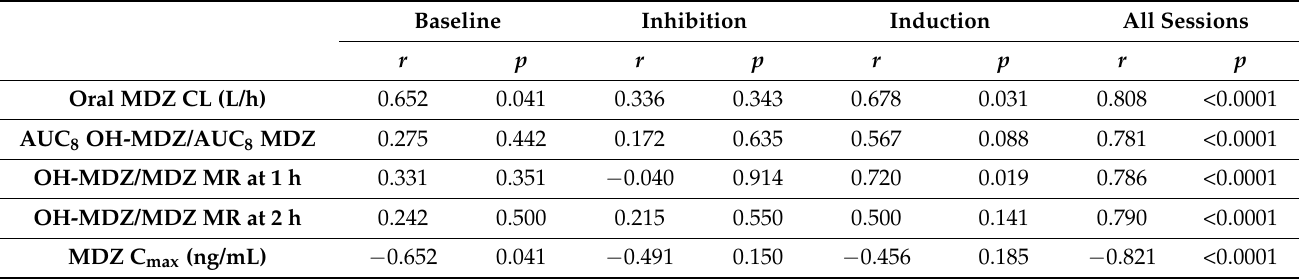
Table 3. Correlation of log-transformed urinary 1 β -OH-DCA/DCA ratio with log-transformed midazolam-based CYP3A4 metrics at baseline, after inhibition, and after induction.